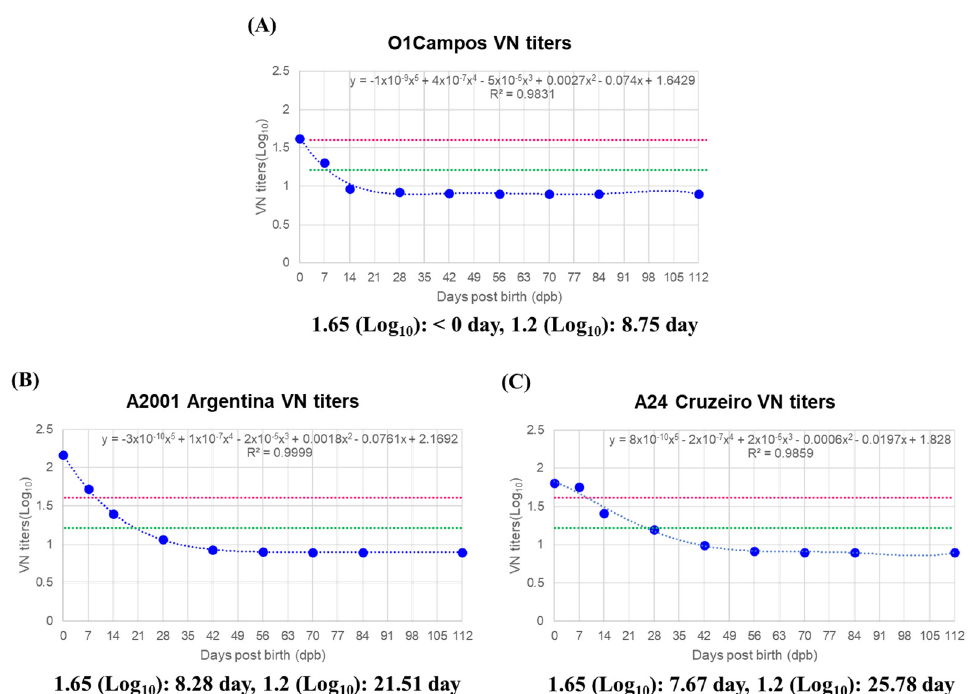
Figure 4. Time kinetics of maternally derived antibodies determined based on VN titers. To under- stand the properties of maternally derived antibodies, five sows and 10 piglets from each sow were screened. For sows, blood was collected 7 days before farrowing. For piglets born to sows, blood was collected on 7, 14, 28, 42, 56, 84, and 112 days post-birth. Virus-neutralizing antibody (VN) titers for O1 Campos, A2001 Argentina, and A24 Cruzeiro were measured in the sampled serum. Data are presented in regression curves for time kinetics and half-life of MDAs. The red dotted line and the green dotted line correspond to VN titers 1.65 (Log 10 ) and 1.2 (Log 10 ), respectively. ( A – C ) represent: ( A ) Time kinetics of MDA based on VN titers for O1 Campos; ( B ) time kinetics of MDAs based on VN titers for A2001 Argentina; ( C ) time kinetics of MDAs based on VN titers for A24 Cruzeiro. The data represent the mean ± SEM of triplicate measurements (n = 5 for sows or 10 piglets/sow).